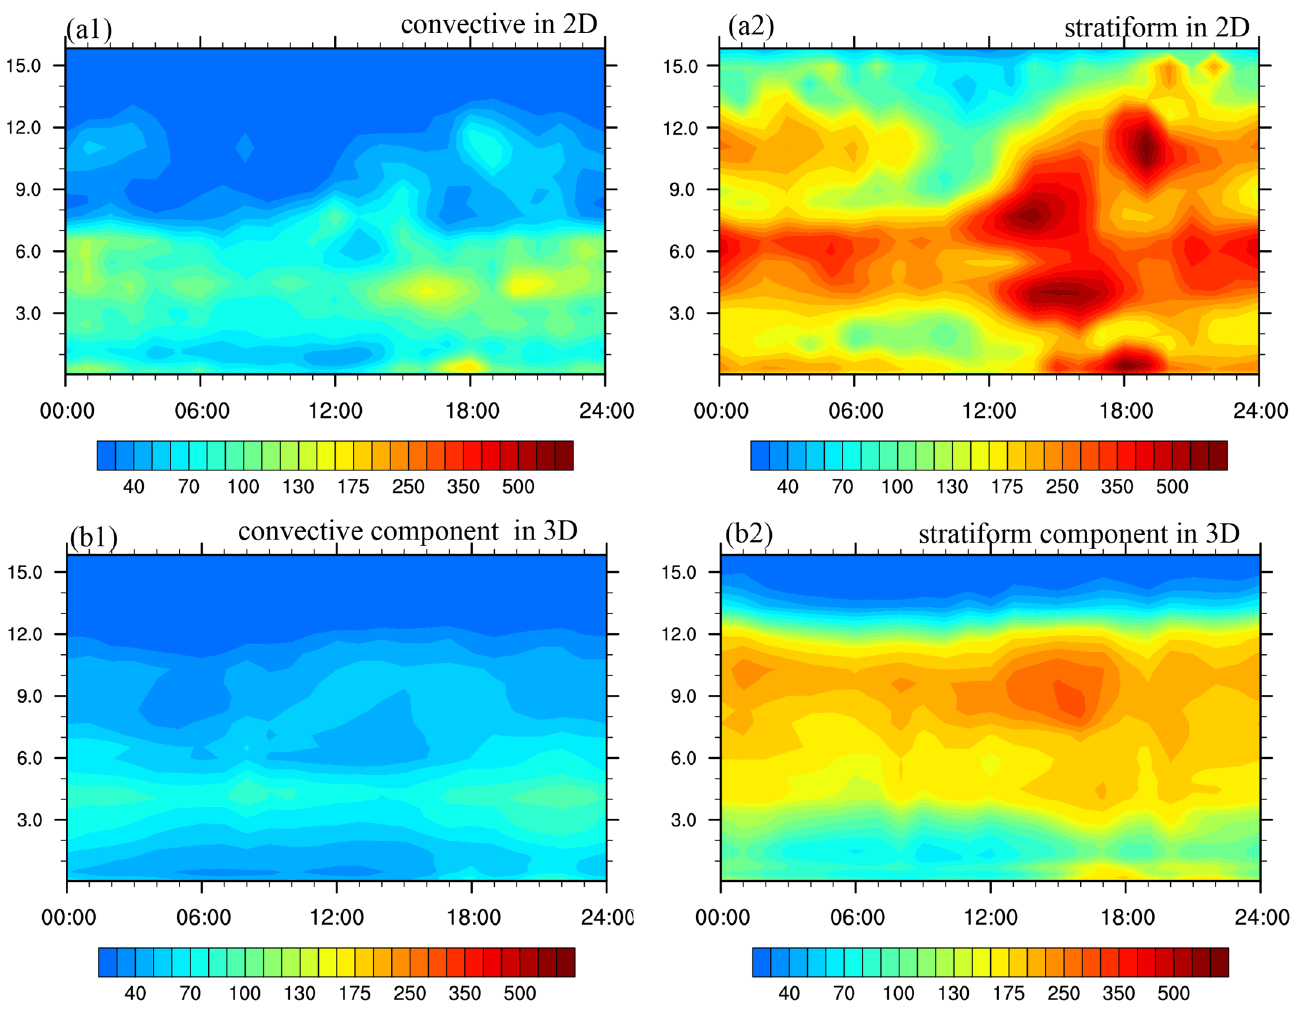
Figure 8. Diurnal cycle of the perturbation kinetic energy (J m − 2 ) in the 2D model runs in ( a1 ) convective regions and ( a2 ) stratiform regions, and the perturbation kinetic energy in the 3D model runs in ( b1 ) convective regions and ( b2 ) stratiform regions.